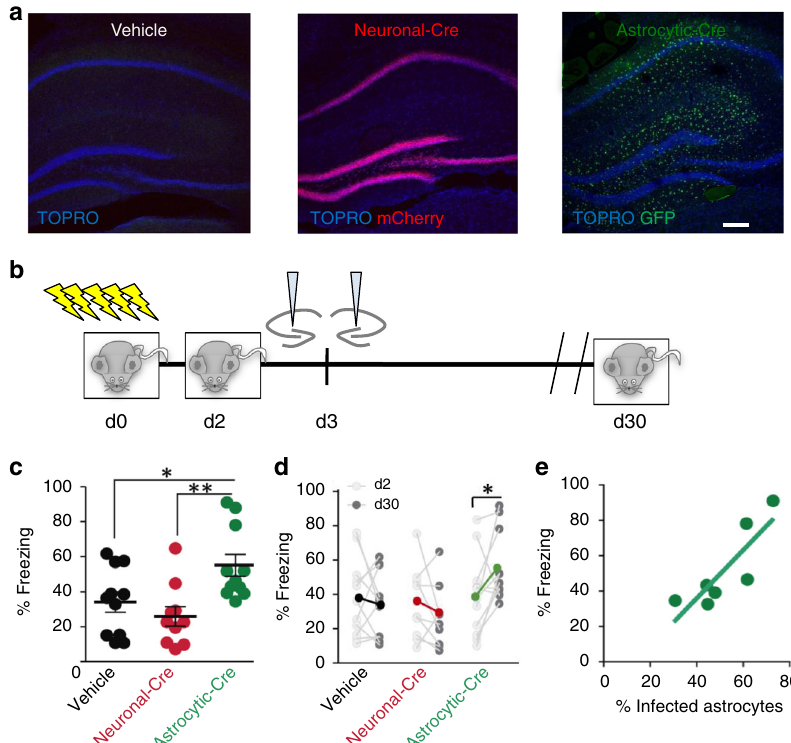
Fig. 9 Deletion of astrocytic p38 α enhances long-term memory. a Representative fl uorescence image of hippocampal sections from p38 α lox/lox mice 4 weeks after in vivo delivery of AAV5- P CaMKII α -mCherry-Cre (Neuronal-Cre) and astrocytic AAV5- P GFAP -GFP-Cre. Scale bar, 150 µ m. Counterstaining with TOPRO for cell nuclei was used to visualize hippocampus morphology. b Cartoon representing the contextual fear-conditioning paradigm used in this study. p38 α lox/lox mice were subjected to contextual fear conditioning on the training day (d0) consisting of fi ve foot shocks. Two days later, mice were brie fl y tested (3 min re-exposure) for fear retrieval (pre-infection test; d2) to check freezing levels before infection. The next day (d3), mice were